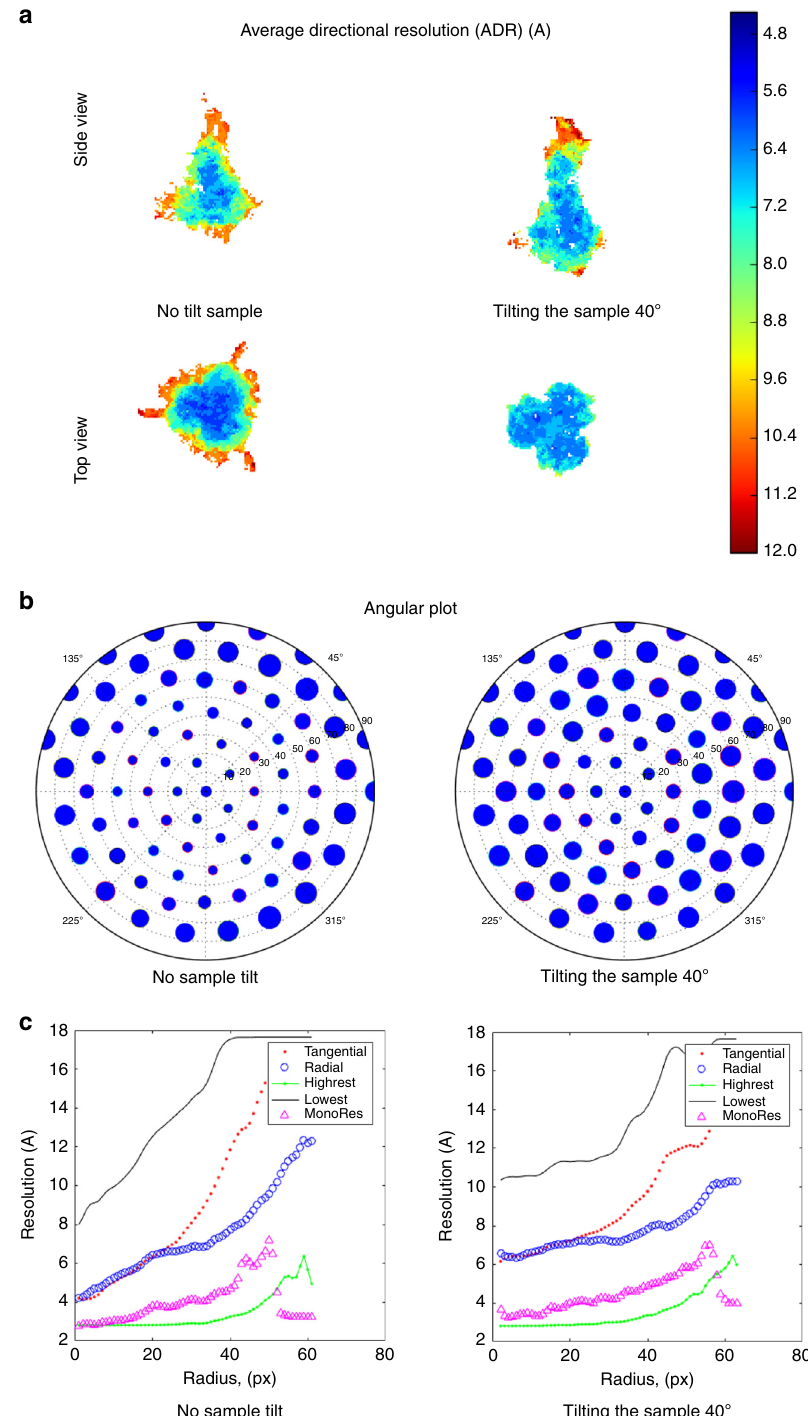
Fig. 3 Results for In fl uenza Hemagglutinin (HA) trimer when the sample is untilted and tilted. a ADR, ( b ) angular plot, and ( c ) radial averages as in Fig.